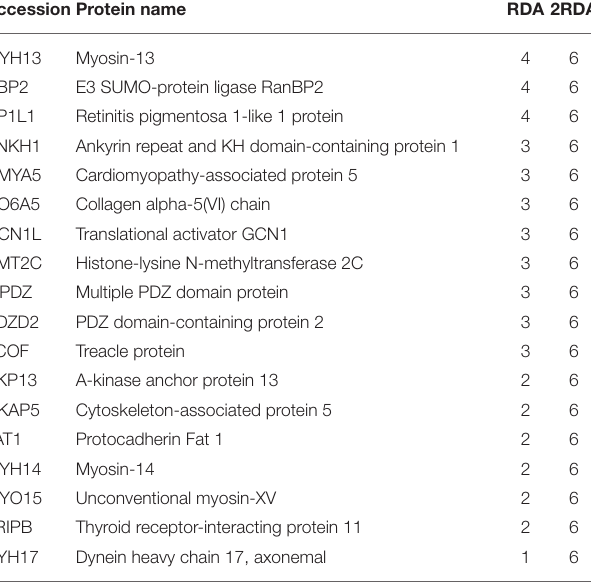
TABLE 1 | Frequency of host proteins found in at least 60% ( n = 6) of at least one of the diet groups and corresponds to the Venn diagram in Figure 2B